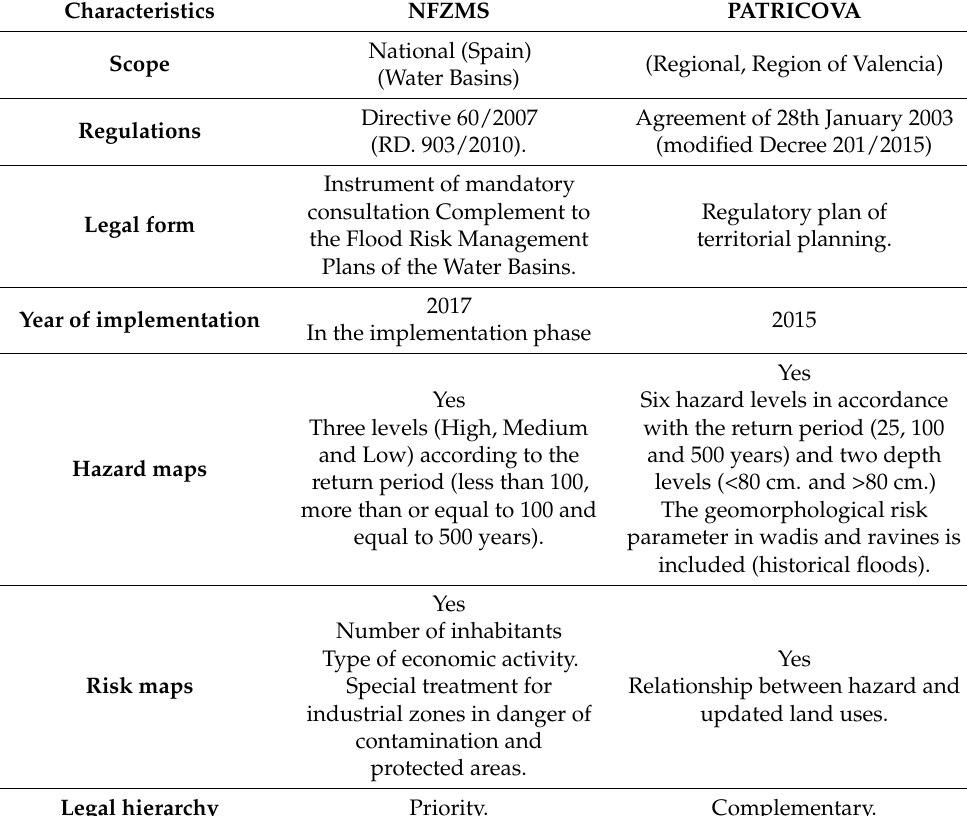
Table 4. Characteristics of the flood risk cartography